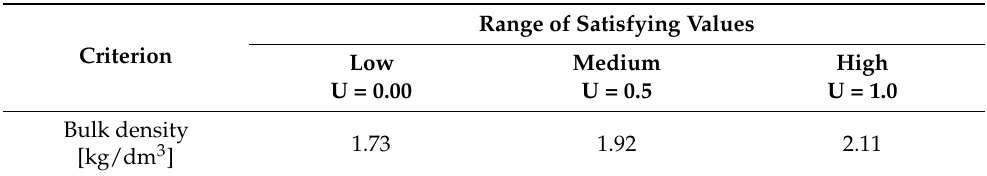
Table 8. Ranges of satisfactory values for the criterion of optimization (bulk density) of modified silicate product with Humus Activ and Biohumus Extra Universal.